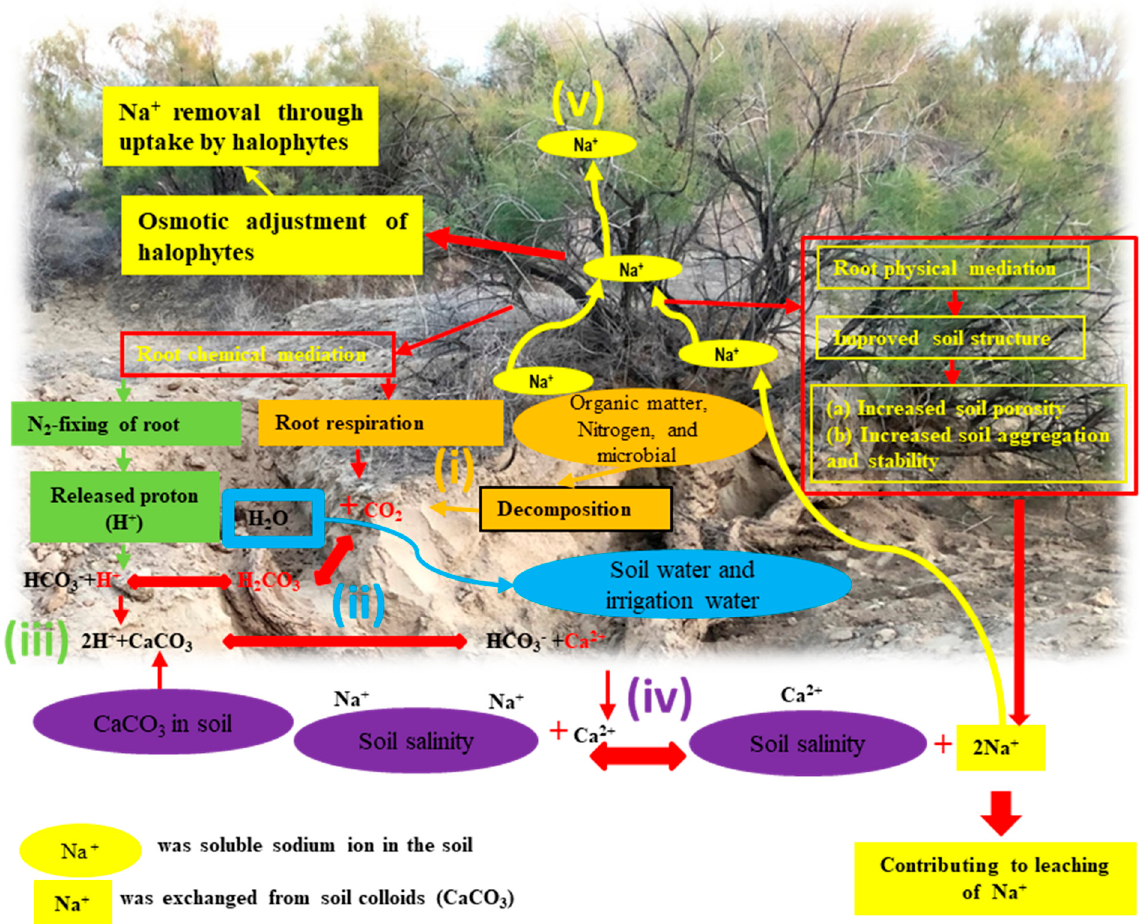
Figure 3. Concept of a suitable mechanism of halophytes’ rhizospheres on salt-affected sandy soil under saline water irrigation (an evacuated soil profile of Tamarix taklamakanensis is in the background). The figure is referenced and updated from [16].